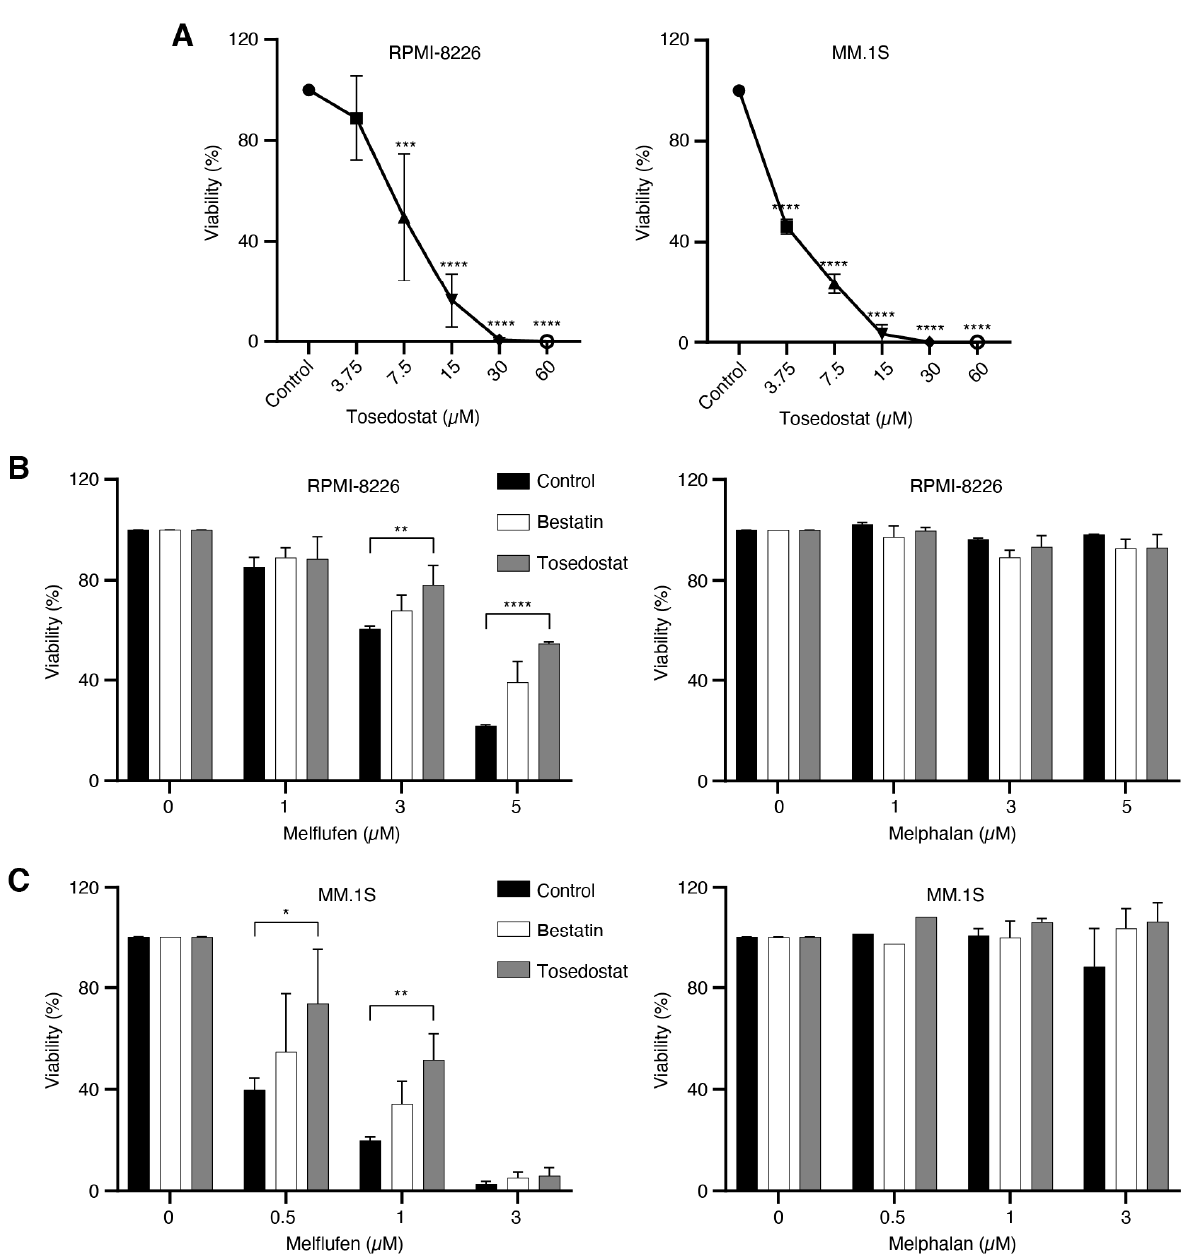
Figure 5. Aminopeptidase inhibitors reduce sensitivity to melflufen in MM cell lines. ( A ) MM cell lines RPMI-8226 and MM.1S were treated with different concentrations of the aminopeptidase inhibitor tosedostat for 48 h, and cell viability was measured using PrestoBlue cell viability reagent. ( B ) RPMI-8226 cells or ( C ) MM.1S cells were pretreated with DMSO (control) or the aminopeptidase inhibitors bestatin (10 μ M) or tosedostat (10 μ M) for 1 h, then either left without additional treatment or treated with three different concentrations of melflufen or melphalan for 15 min, after which the medium was replaced. After 48 h, cell viability was measured using PrestoBlue cell viability reagent. Statistical significance is indicated as * p ≤ 0.05; ** p ≤ 0.01; *** p ≤ 0.001; **** p ≤ 0.0001. DMSO: dimethyl sulfoxide